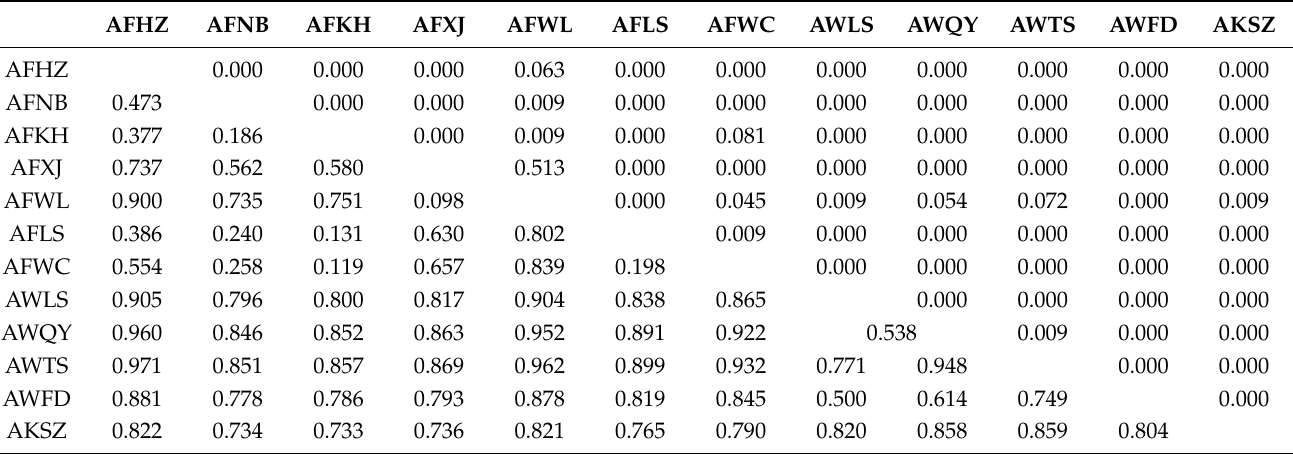
Table 2. Matrix of pairwise F ST values among twelve populations in three Acrossocheilus species based on the mitochondrial cyt b + D-loop region (below diagonal) and p values (above diagonal).